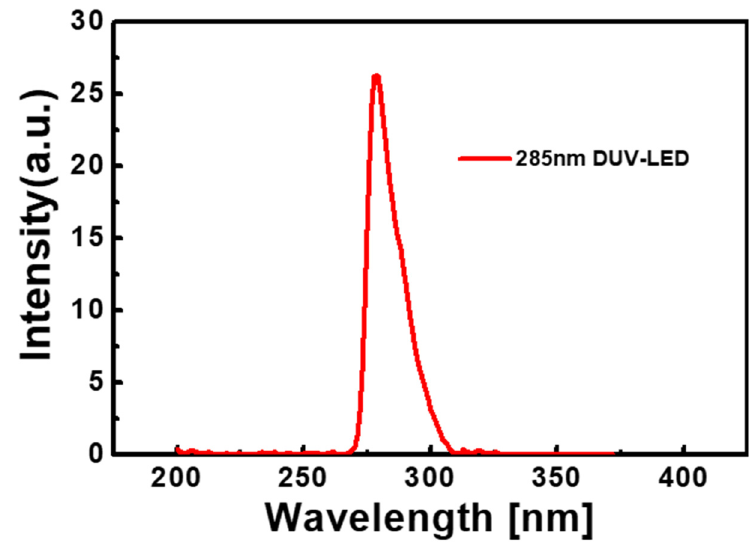
Figure 2. Normalized emission spectrum generated at 100 mA forward current of the proposed.